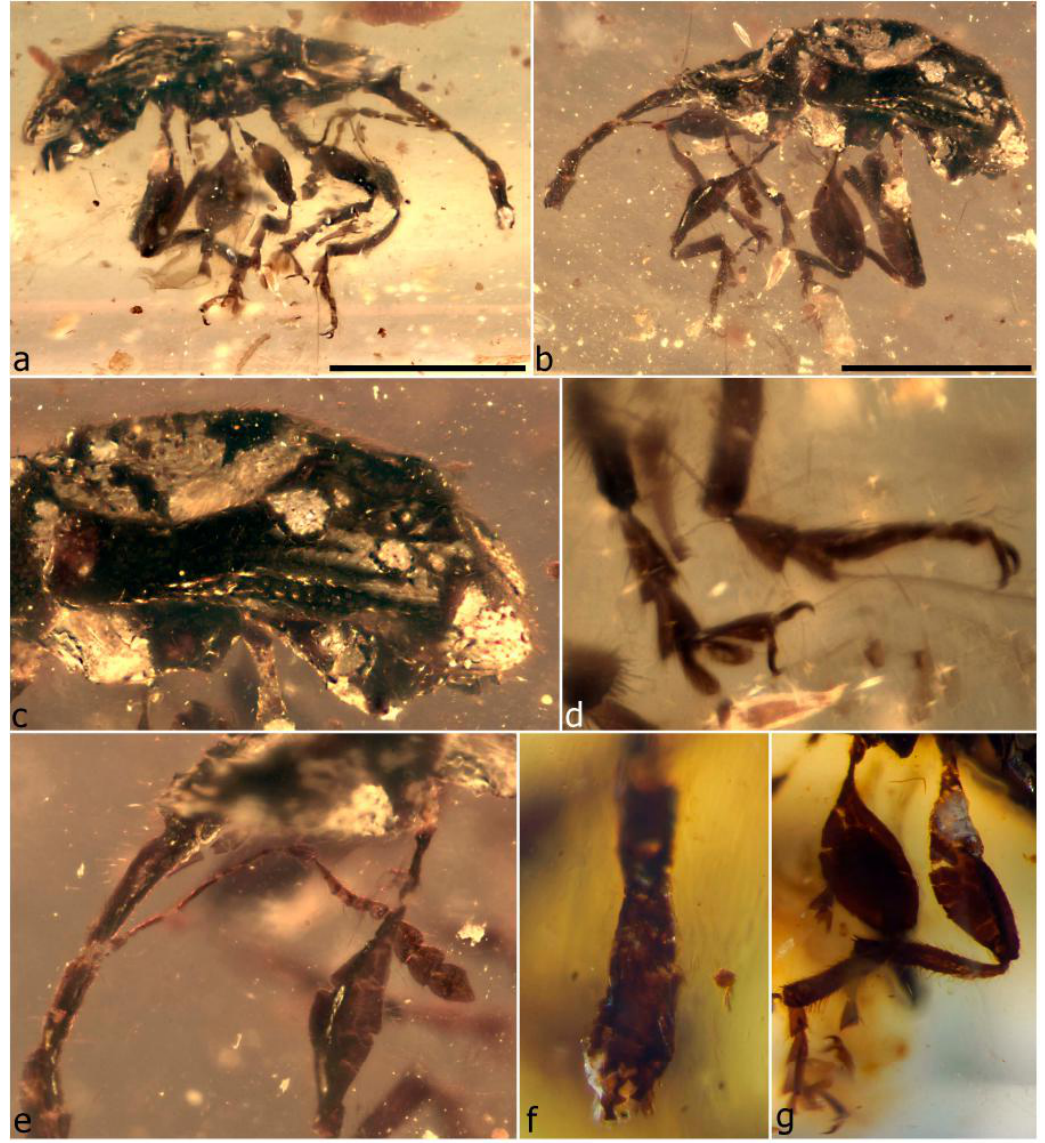
Figure 47. Ocriocis binodosus . Habitus, right lateral ( a ); habitus, left lateral ( b ); elytra, left lateral ( c ); protarsi ( d ); rostrum and left antenna, left lateral ( e ); apex of rostrum and mandibles, dorsal ( f ); middle and hindlegs, showing spurs and carinulae ( g ). Scale bars: 1.0 mm (a,b). Material examined. Holotype (NIGP154220): poorly preserved, heavily distorted (crumpled) and somewhat decomposed specimen, with head retracted into prothorax, rostrum and